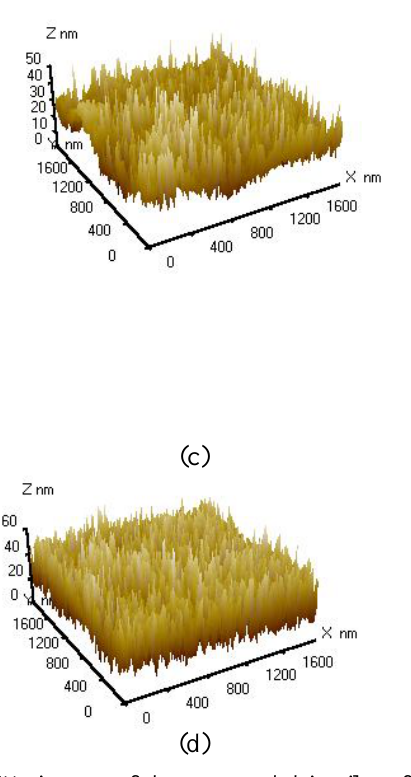
Fig. 1. AFM images of the sputtered thin silver films (50 nm) (a) silanized with APTES and condensate in NaOH solution for 5 (b), 30 (c) and 60 min (d).